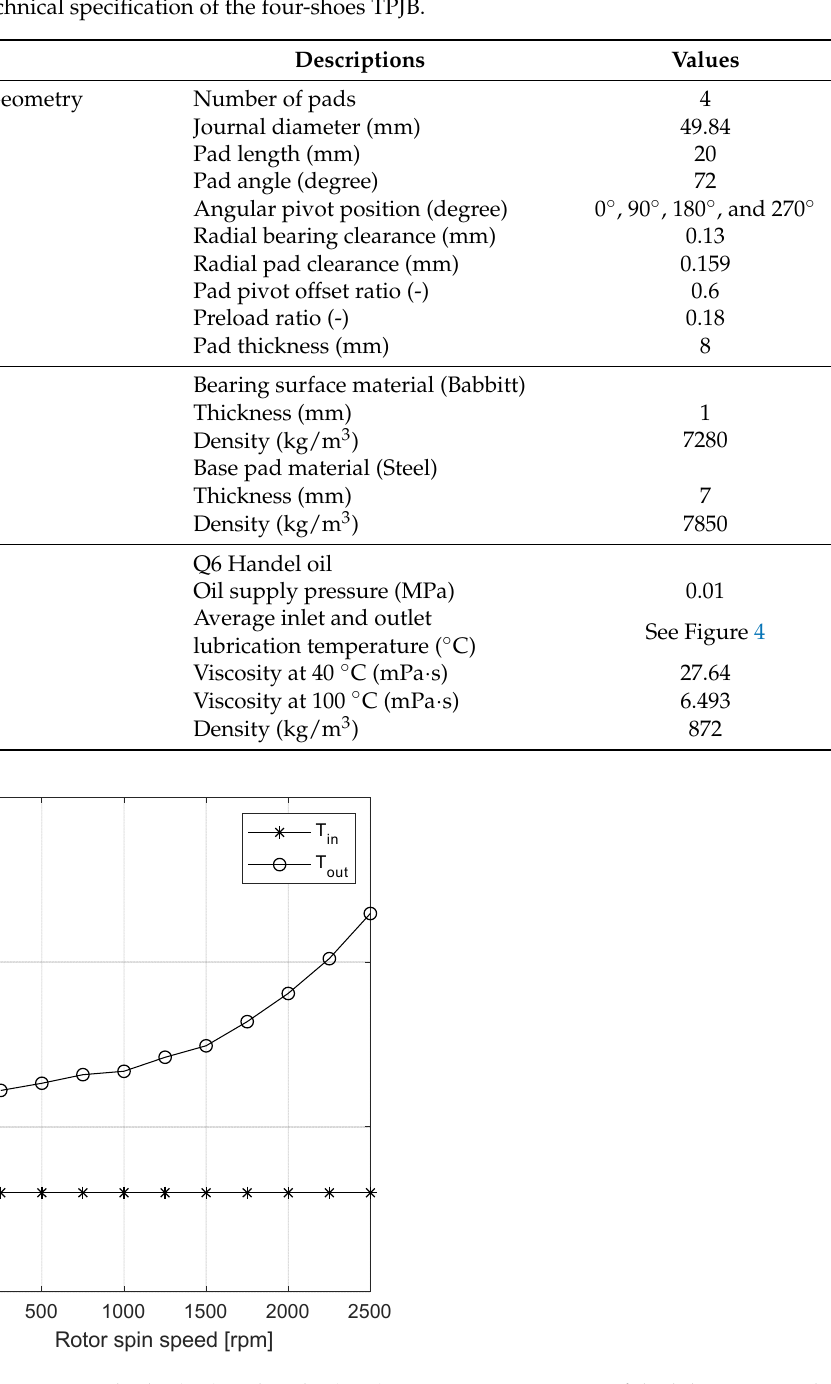
Figure 4. The measured inlet (T in ) and outlet (T out ) average temperatures of the lubricant are plotted as a function of the rotor speed.